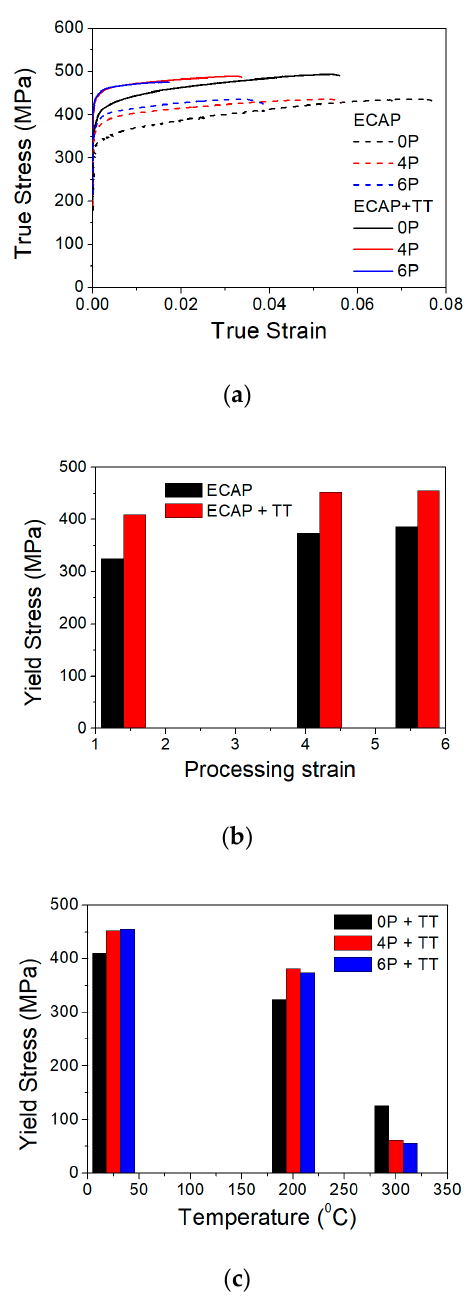
Figure 12. ( a ) Tensile macroscopic stress-strain curve of the GWZ831 alloy for the as-extruded alloy and after ECAP processing with/without thermal treatment at 200 ◦ C for 24 h. ( b ) Evolution of the yield stress as a function of the processing strain of the GWZ831 alloy for the as-extruded alloy and after ECAP processing with/without thermal treatment at 200 ◦ C for 24 h. ( c ) Evolution of the yield stress as a function of the tensile temperature of the GWZ831 alloy for the as-extruded alloy and after ECAP processing aged at 200 ◦ C for 24